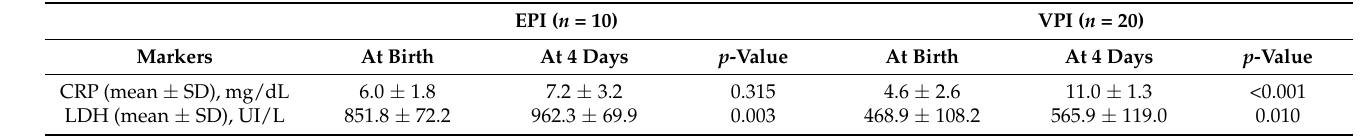
Table 3. Comparison of inflammatory markers measured at birth and 4 days after birth between extremely premature newborns and very premature newborns.